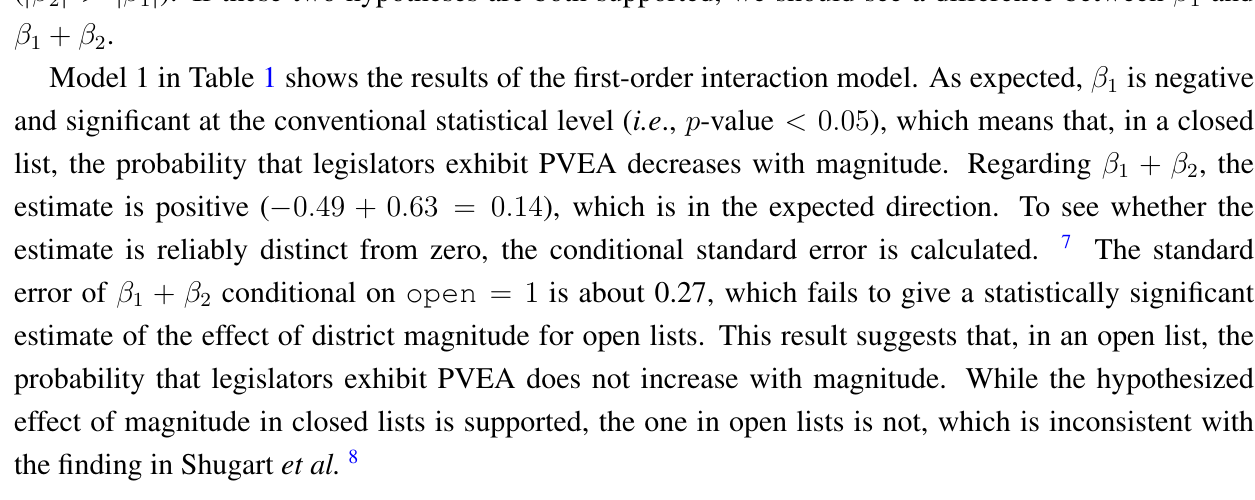
Table 1. Personal vote-earning attributes: Coefficients